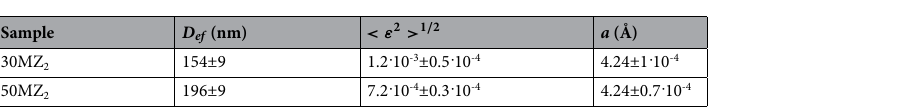
Table 2. Structural parameters taken from Rietveld refinement of TiN for samples thermal treated at 1400 °C.